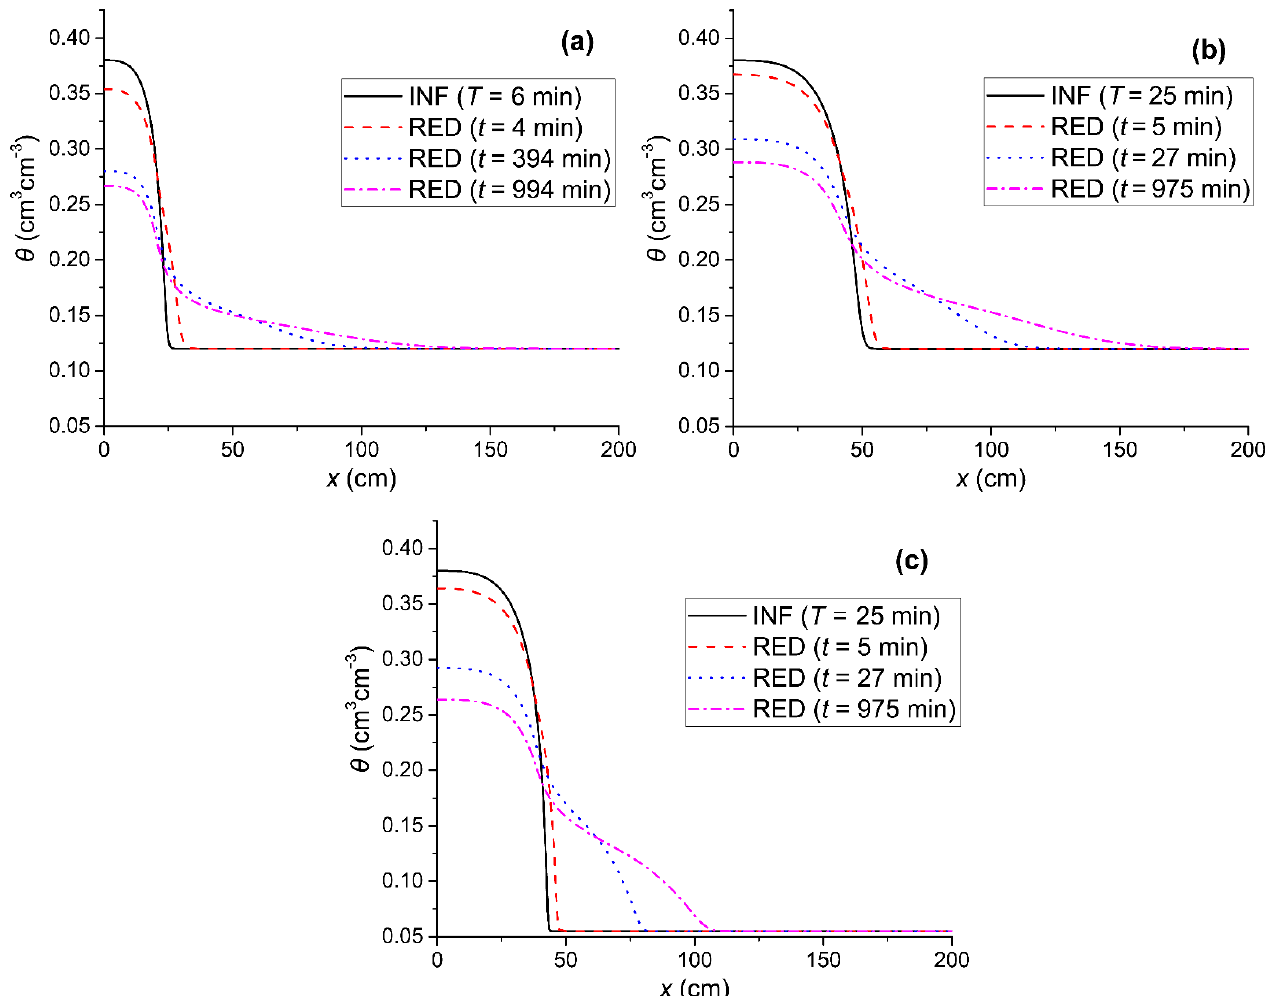
Figure 6. The soil water content profiles of the initial infiltration (INF) and the redistribution (RED) water content profiles for several cases of infiltration water depths, I, and different values of the initial water content. ( a ) The profiles for θ o = 0.12 cm 3 cm − 3 and duration of infiltration T = 6 min, corresponding to I = 5,34 cm; ( b ) the profiles for θ o = 0.12 cm 3 cm − 3 and duration of infiltration T = 25 min, corresponding to I = 10.9 cm; and ( c ) the profiles for θ o = 0.055 cm 3 cm − 3 and duration of infiltration T = 25 min, corresponding to I = 12.3 cm.